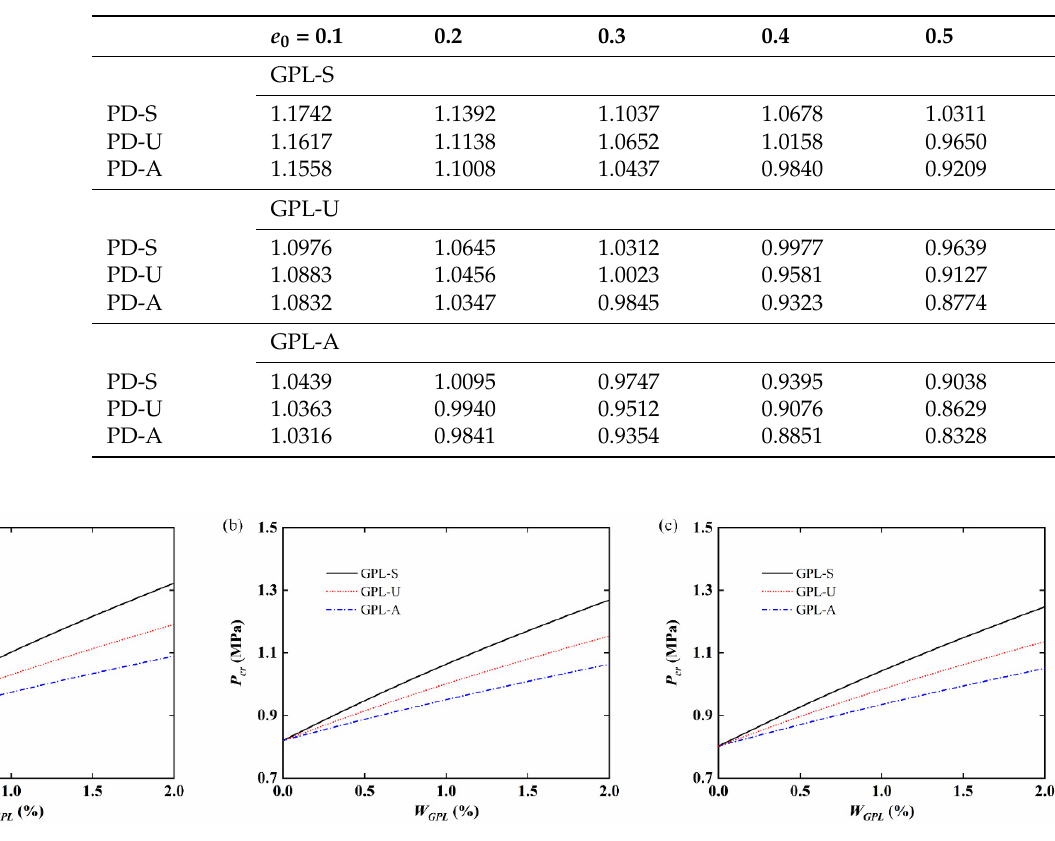
Table 4. Critical pressure of ring-stiffened porous GPLRC cylindrical shells for different porosity coefficients and porosity distributions.